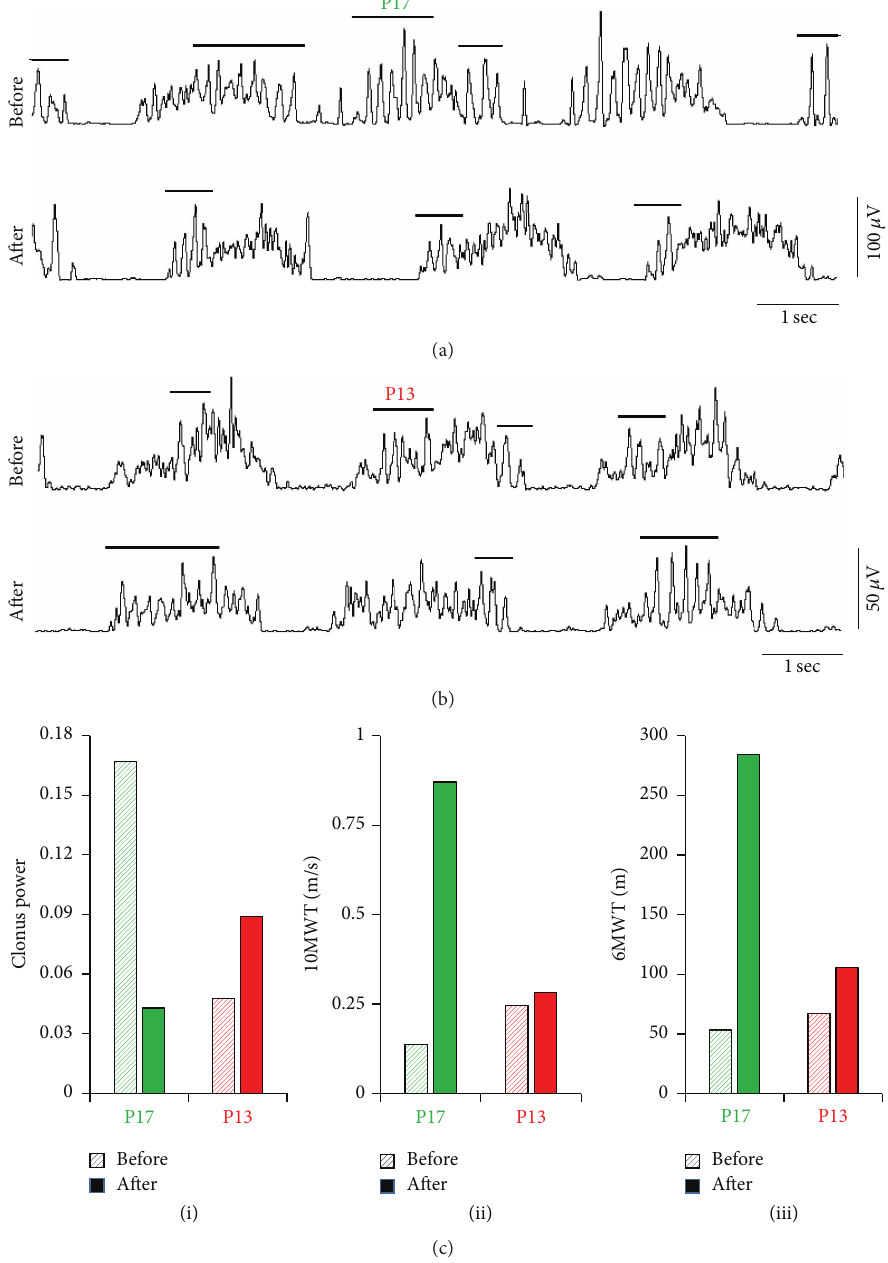
Figure 4: Clonus in the soleus muscle during unperturbed walking. (a) and (b) Rectified and smoothed (dual-pass, zero phase, 20 Hz low- pass, 2nd-order, digital Butterworth filter, for display purposes) EMG traces from the soleus muscle during unperturbed walking on a level treadmill, recorded before (i.e., at Baseline 2) and after both phases of training (i.e., at Month 6), from participants exhibiting (a) decrease and (b) a small increase in clonus after the training. (c)(i) The change in clonus over both phases of training (i.e., change from Baseline 2 to end of Month 6) and the corresponding changes in (ii) the 10-Meter Walk Test (10MWT) and (iii) 6-Minute Walk Test (6MWT) for both participants are shown for comparison. Horizontal lines indicate clonic EMG